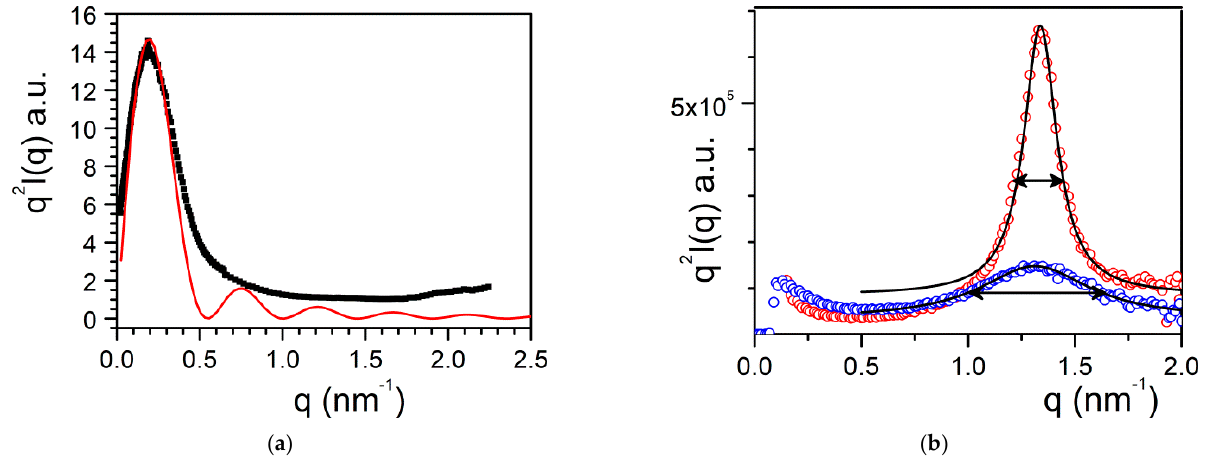
Figure 13. Scattering patterns plotted by means of a Kratky plot ( q 2 I(q) vs. q ) for: ( a ) SANS, BHPB-10/o-xylene; C = 0.01 g/cm 3 ; red line fit with relation 21. Note the peak is due to the representation, and is therefore not a Bragg peak [38]. ( b ) Scheme 0. C ( ); C = 0.04 g/cm 3 . Here the peak is a Bragg peak as it is also seen in a I(q) vs. q plot. The curves are fitted with relation 16 and the FWHM, Δ q , is shown by double arrows. [39].